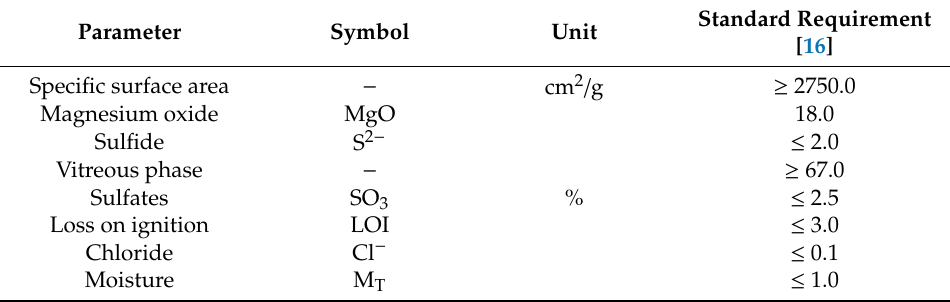
Standard Requirement [16]